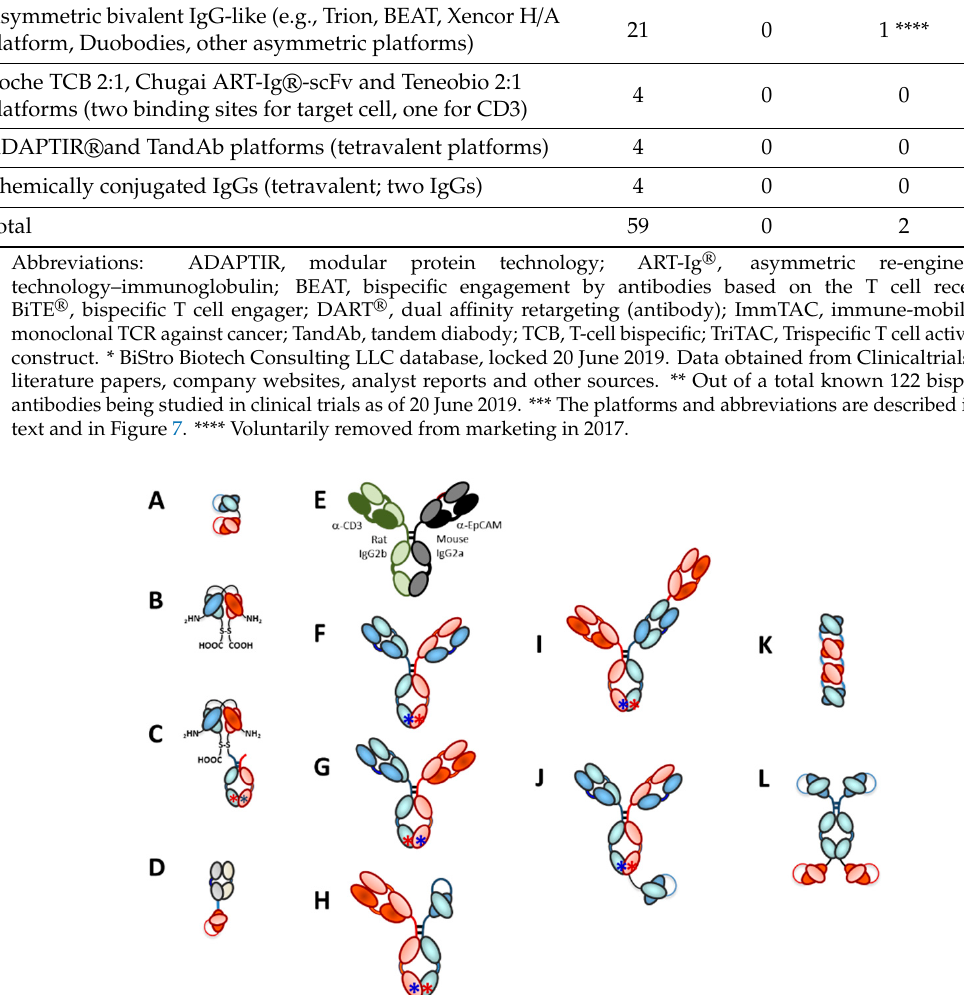
Table 2. Bispecific antibody T- and NK-cell redirecting antibody formats represented in clinical trials * , **. Bispecific T- or NK-Cell Redirecting Antibody Format *** Short half-life bivalent fragments (e.g., BiTE®s, DART®s, ImTACs, other bivalent fragments) Half-life extended bivalent fragments (e.g., DART®-Fc, Extended half-life BiTE®s, TriTAC) platform, Duobodies, other asymmetric platforms) platforms (two binding sites for target cell, one for CD3 )